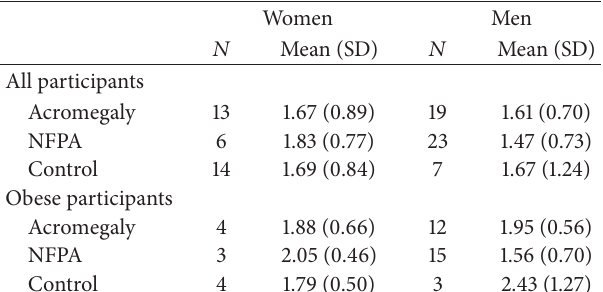
Table 4: Mean scores on the BIDQ by